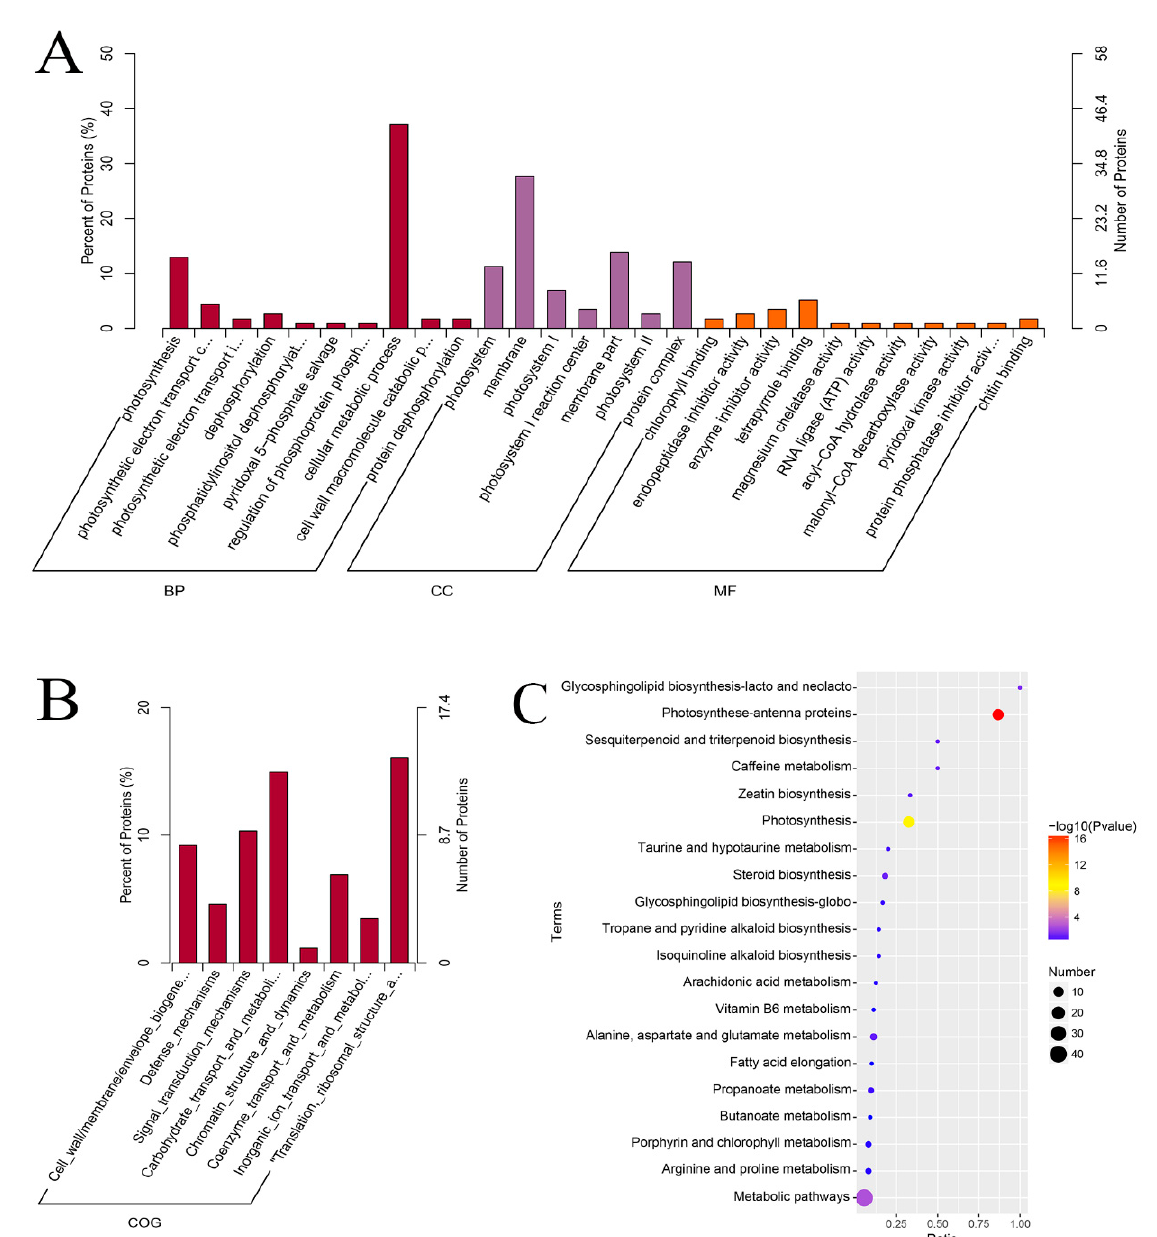
Figure 5. ( A ) Differentially accumulated proteins in green and mutant leaves via gene ontology (GO) classification. ( B ) Green and mutant leaf protein categorization by clusters of orthologous groups (COG). ( C ) Pathway enrichment analysis of DAPs between mutant and green leaves. Nineteen pathways ( p -value < 0.05) were selected for this analysis.